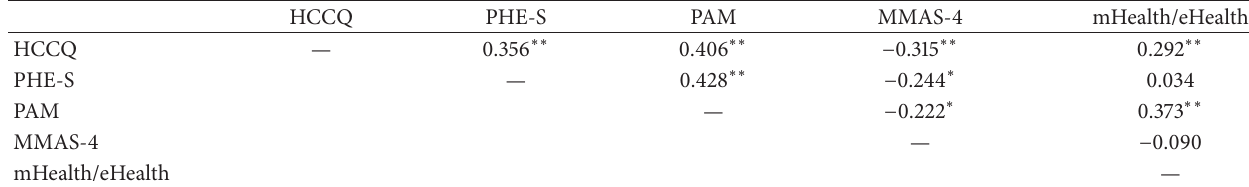
Table 3: Linear correlations coefficients between psychometric measures and frequency of mHealth/eHealth use.